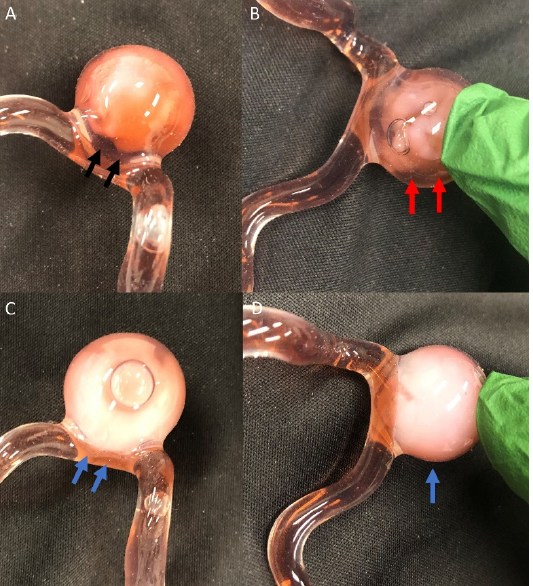
Figure 2. Photosensitive Hydrogel Polymer embolization of the model aneurysm using the injection catheter lighting ( A , B ) versus balloon lighting ( C , D ), with the black arrows demonstrating residual neck remnant of the aneurysm, the red arrows showing unfilled aneurysm at the edges after the injection catheter lighting, and the blue arrows showing complete filling of aneurysm, including the neck, using the balloon lighting.